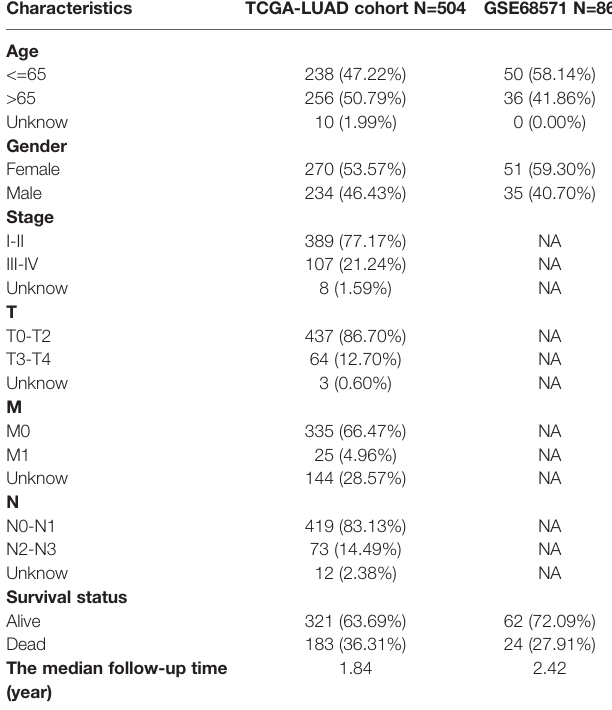
TABLE 1 | Clinicopathological characteristics of LUAD patients from TCGA and GSE68571 databases.